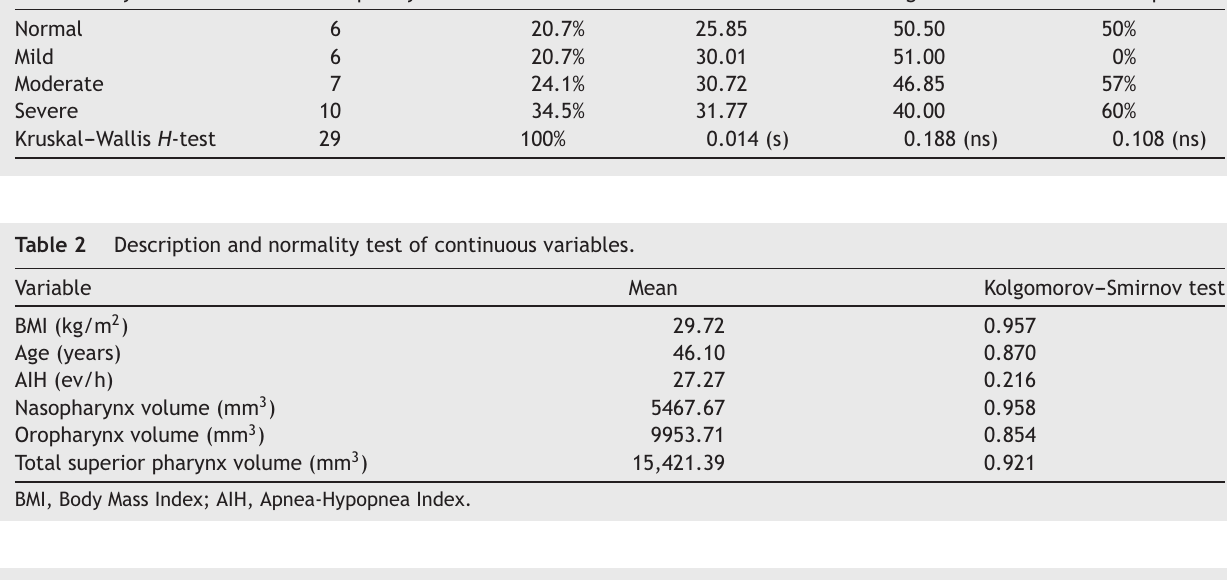
Marginal Homogeneity test, Dahlberg’s error and Intraclass Correlation Coefficient (ICC) for the two volume determi- nations in mm 3 .